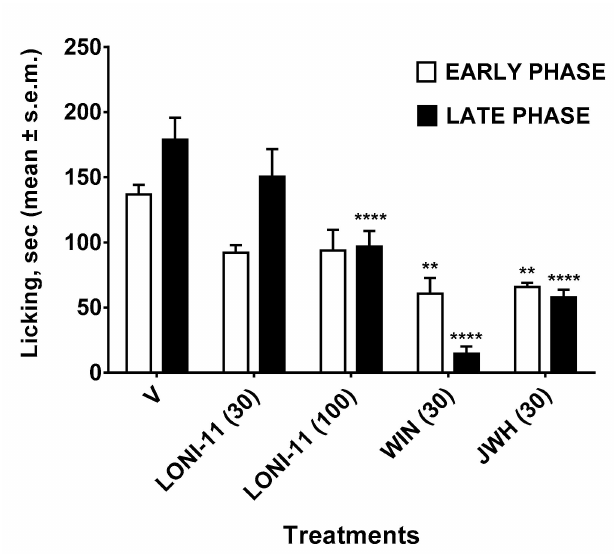
Figure 5. E ff ects induced in the early (white bars) and in the late (black bars) phase of the formalin test by vehicle (V, saline containing 0.9% NaCl in the ratio DMSO:saline 1:3 ( v / v )), LONI11, WIN 55,212-2 and JWH-018 (JWH). The compounds were injected subcutaneously (s.c.) at a single dose (30–100 µ g in 20 µ L) 15 min before formalin injection (20 µ L; s.c.). Early: Licking activity recorded from 0 to 10 min after formalin administration. Late: Licking activity recorded from 15 to 40 min after formalin administration. The results obtained are expressed as the mean ± S.E.M.; ** is for p < 0.01 and **** is for p < 0.0001 vs. V (vehicle-treated animals). N =